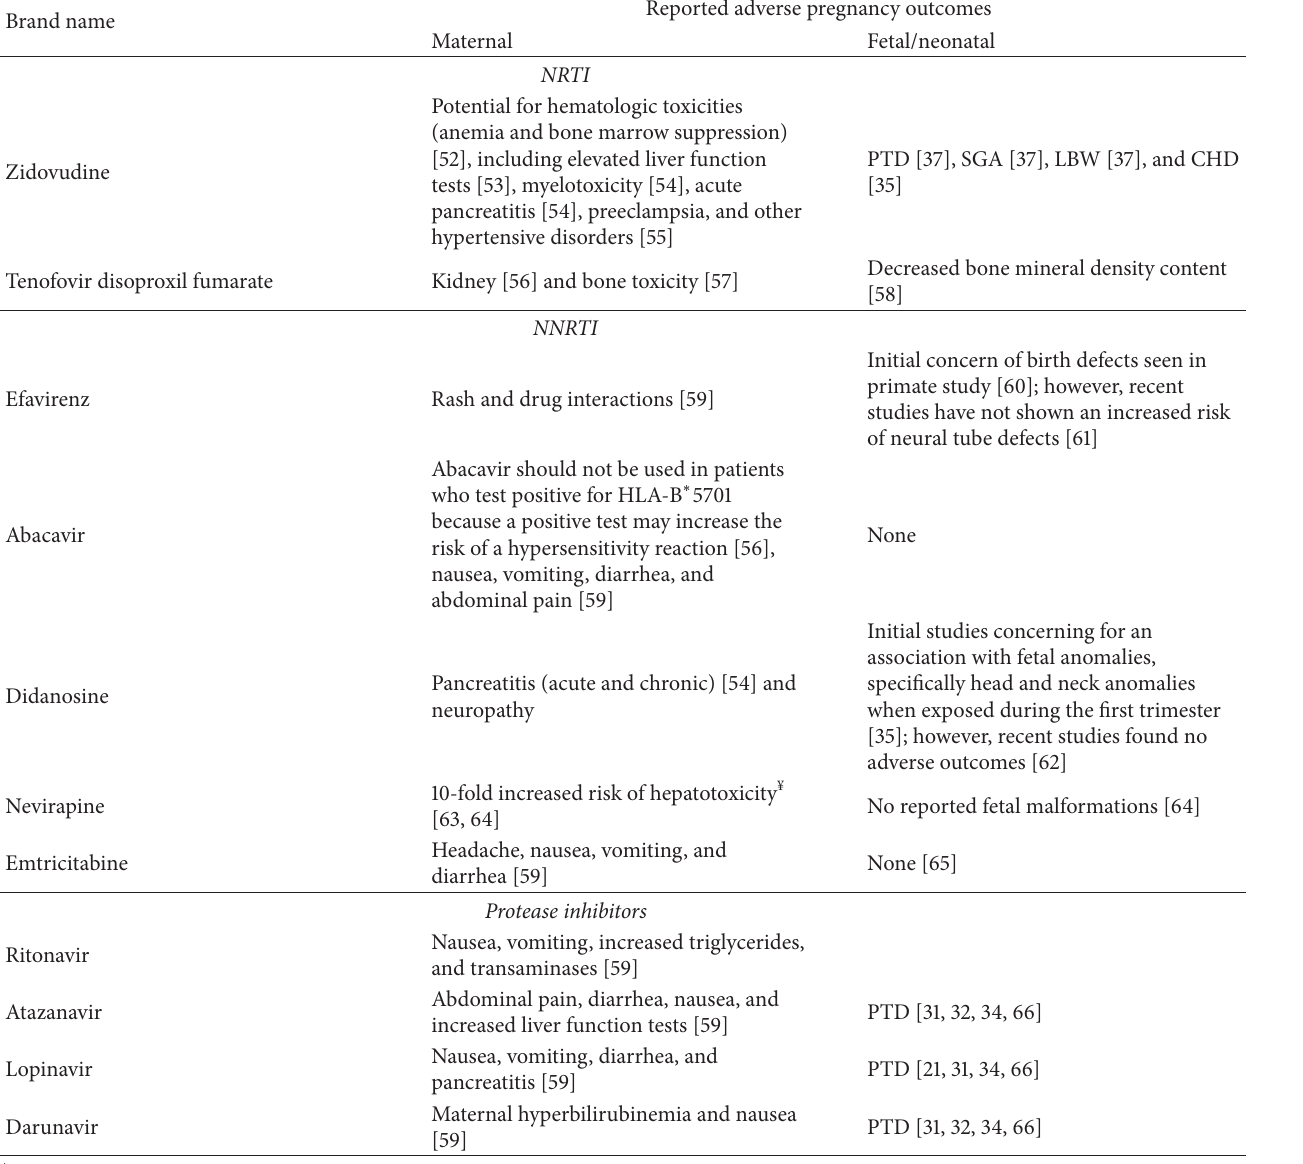
∗ Table provides a short list of the updated ARV’s and their reported safety issues. ¥ Nevirapine can cause fatal and severe hepatotoxicity among women with CD4 lymphocytes > 250 cells/ 𝜇 L. NRTI:nucleosideornucleotidereversetranscriptase inhibitor, NNRTI:nonnucleoside ornonnucleotide reversetranscriptaseinhibitor, PTD:pretermdelivery (delivery prior to 37 weeks), SGA: small for gestational age (birth weight less than the 10th percentile for their gestational age), LBW: low birth weight (birth weight less than 2500 grams), and CHD: congenital heart